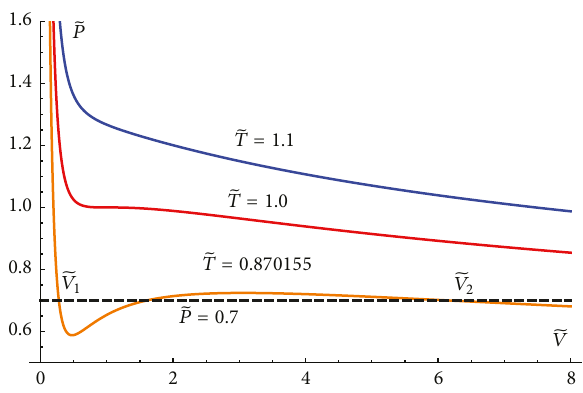
. The phase transition ̃𝑃 = 0.7 equally